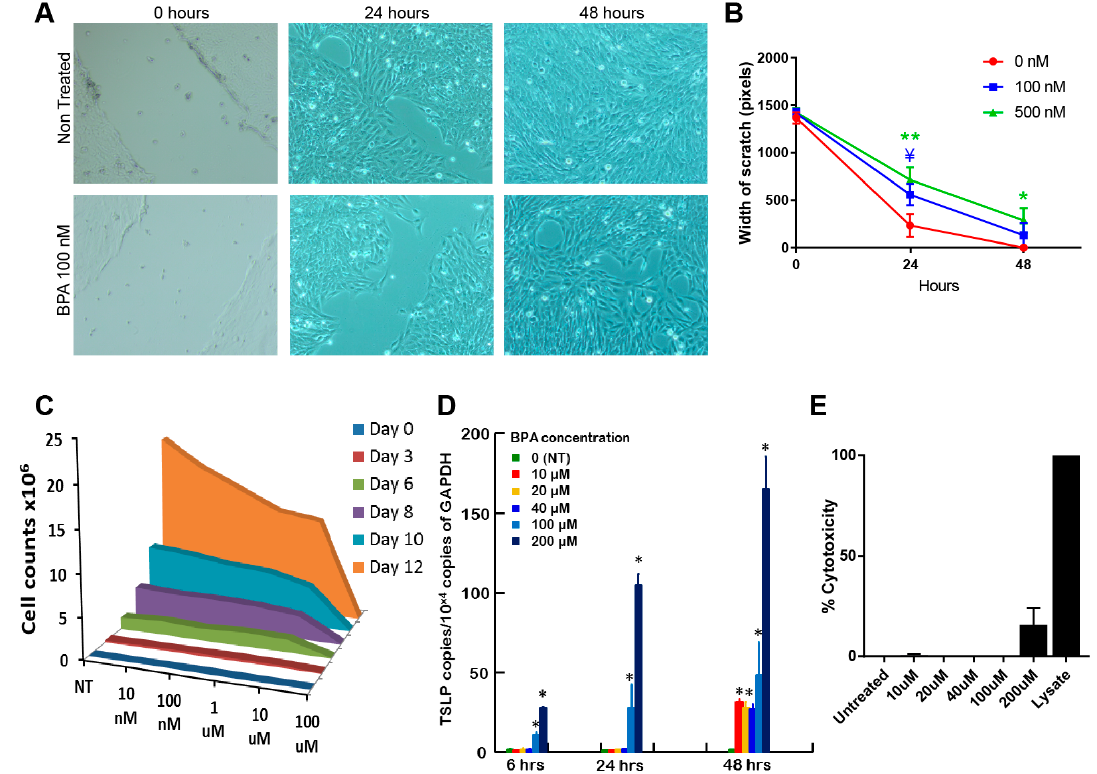
Figure 1. Bisphenol A has an inhibitory effect on BEAS-2B epithelial cell proliferation and wound healing. ( A) Wound healing assay. Cells were grown to complete confluency, and monolayers were scratched with a p10 pipet tip. Wound closure was monitored over a 48 h period. Representative images from two experiments. ( B) Quantification of wound closure rates using scratch width measured in ImageJ. Representative quantification from two experiments. ( C) Inhibitory effect of bisphenol A (BPA) on long-term BEAS-2B epithelial cells proliferation in culture. Data shown from experiment performed one time. ( D) BEAS-2B expression of TSLP induced by exposure to BPA.